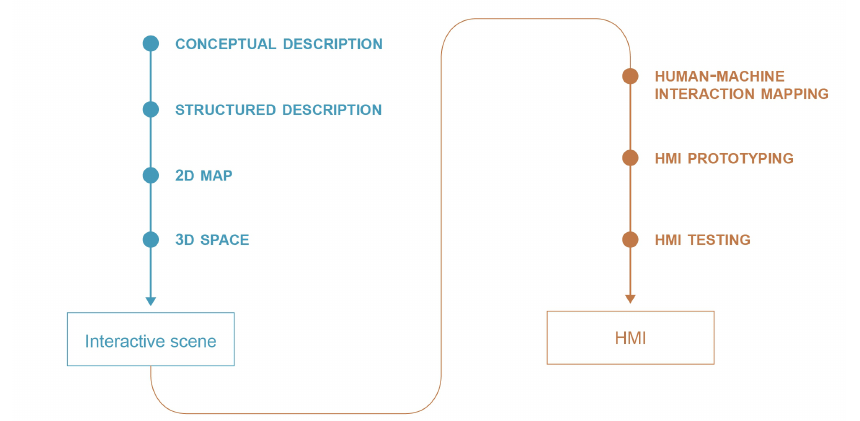
Figure 1. Proposed technical approach.